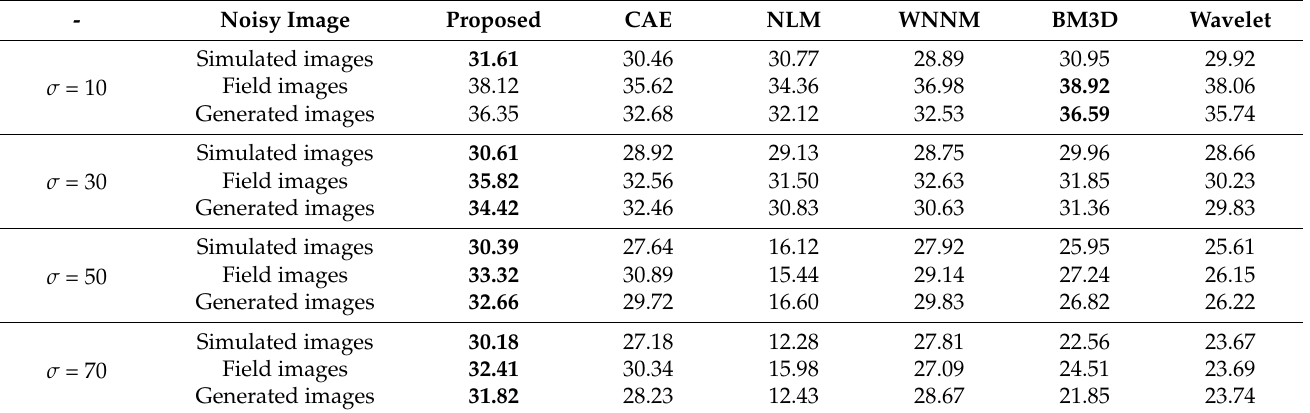
Table 1. Average PSNR (dB) for different standard deviations with various denoising